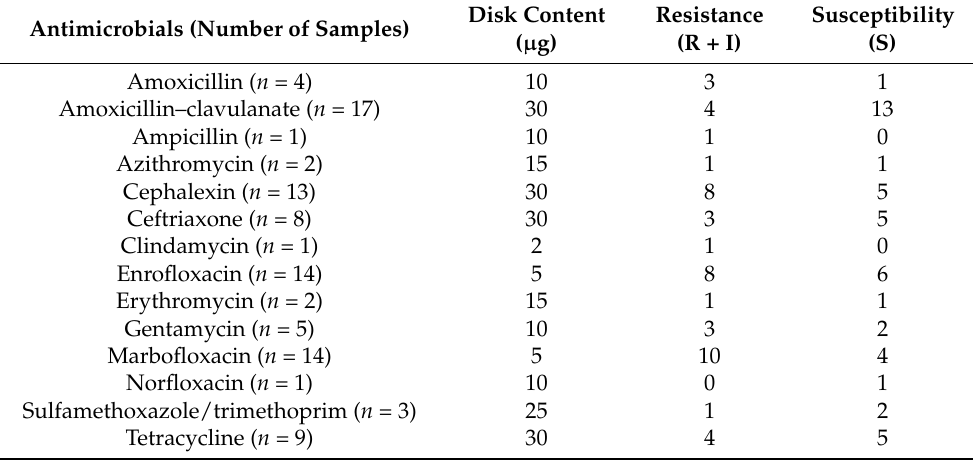
Table 8. Summary of antimicrobial susceptibility tests for 16 cases of cats with pyothorax. Antimicrobials (Number of